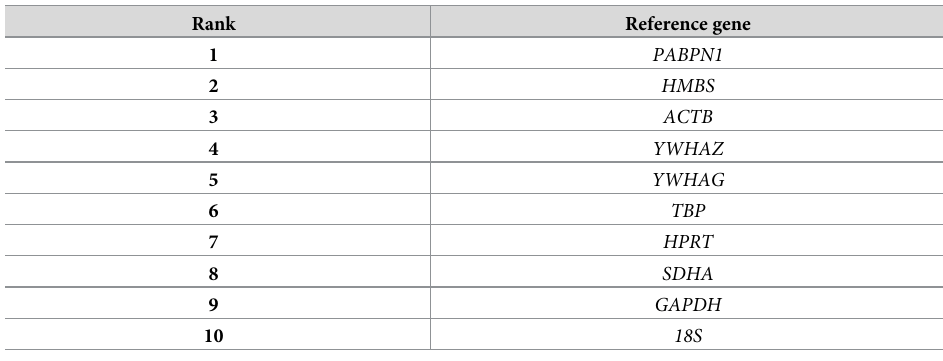
Table 5. Consensus ranking of reference